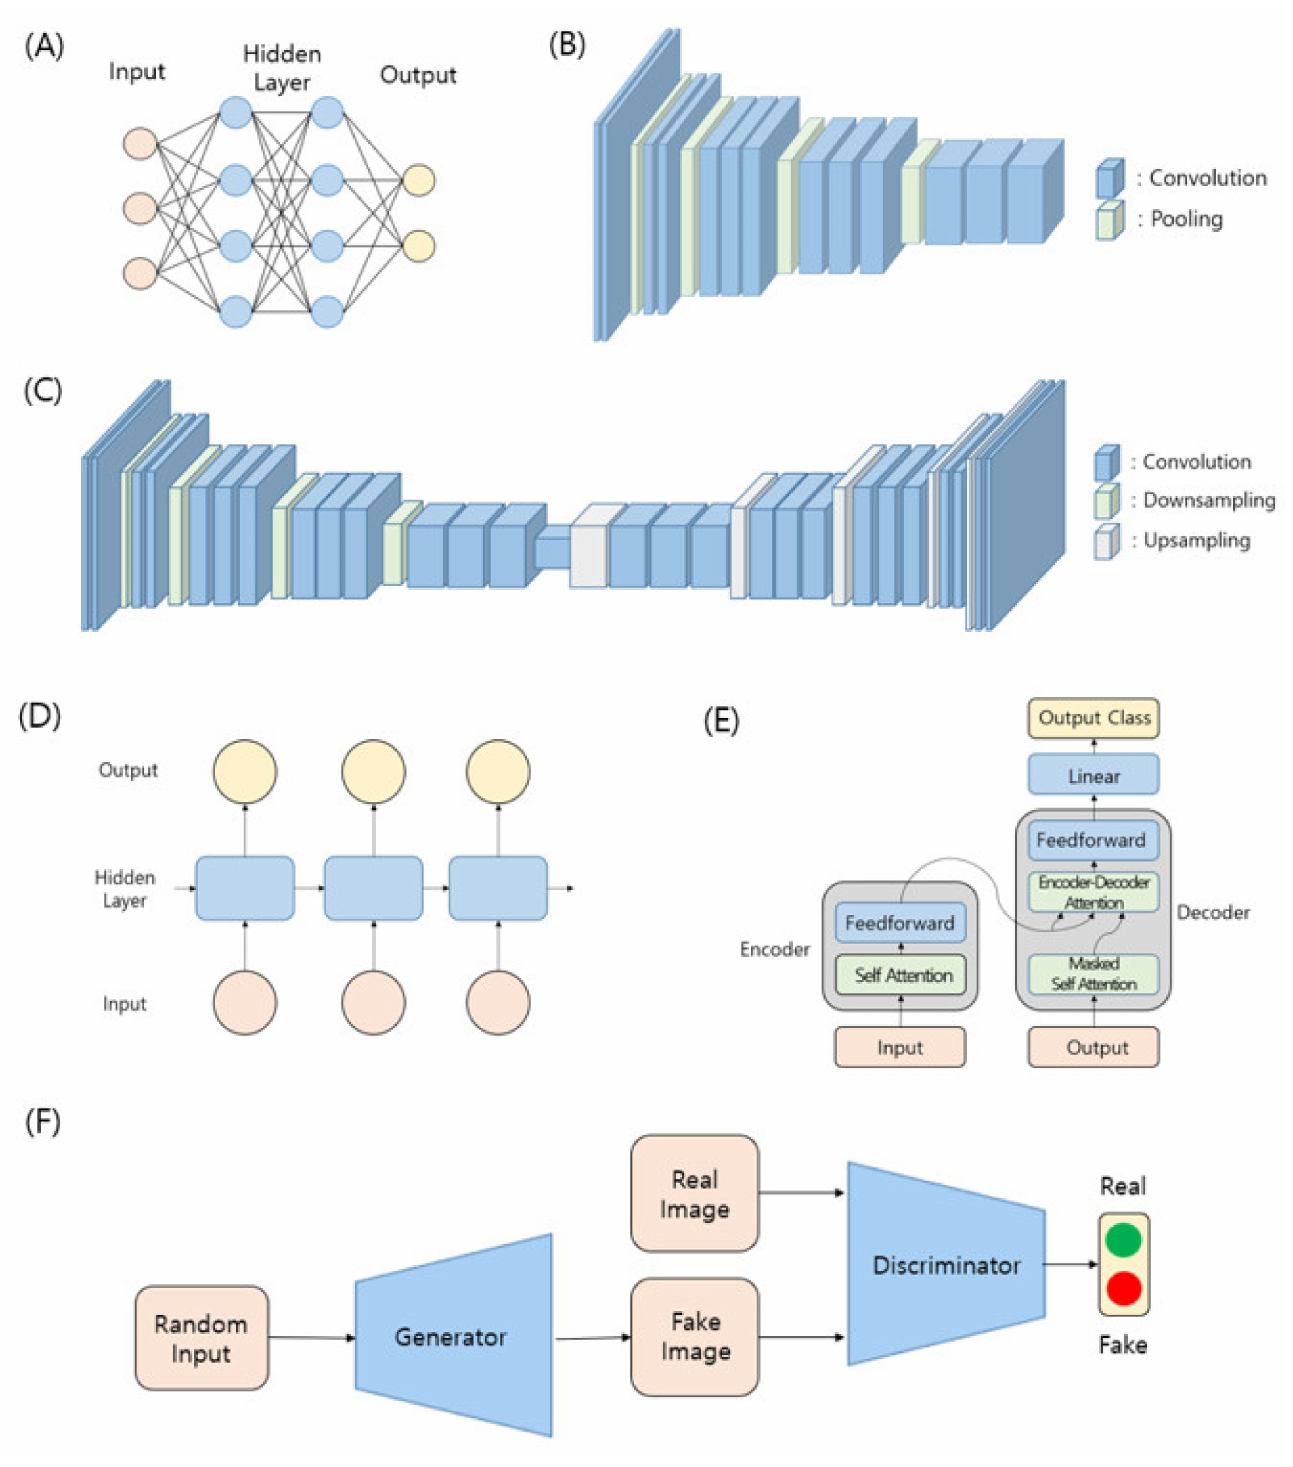
Figure 2. A visualization of deep learning architectures. ( A ) Multi-Layer Perceptron. ( B ) CNN based feature network [44]. ( C ) Encoder–Decoder architecture. ( D ) Recurrent neural network. ( E ) Transformer [45]. ( F ) Generative adversarial network